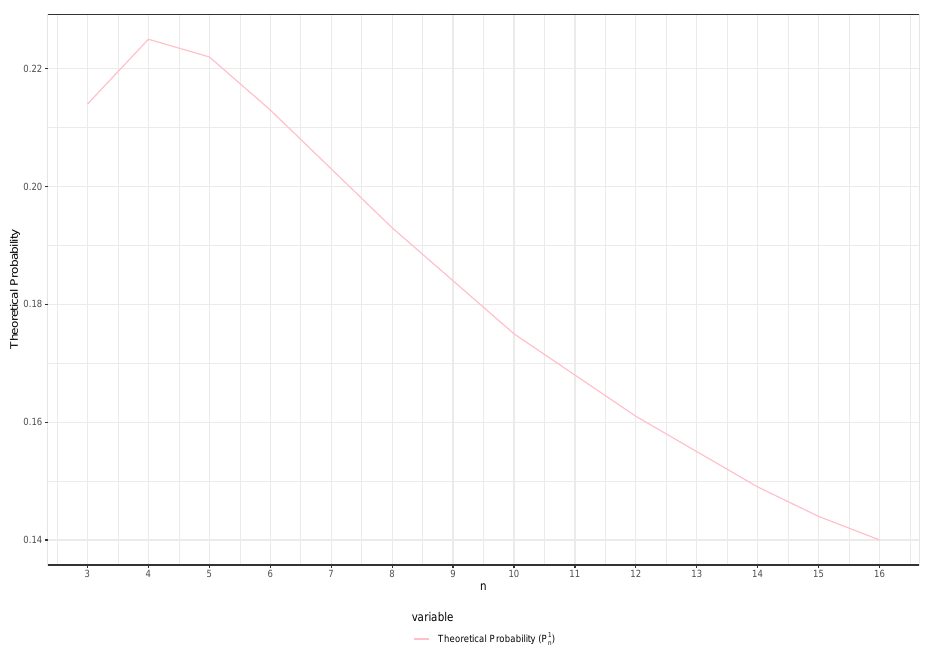
Figure 3. The curve of the theoretical probabilities P 1 n ( y -axis), as a function of n ( x -axis), for n = ( 3,16 )